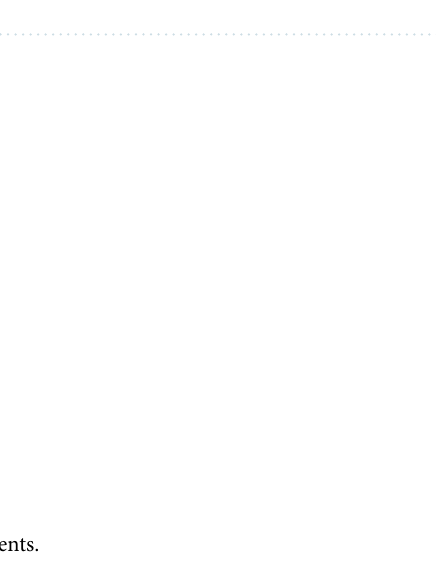
Table 1. The candidate miRs in breast cancer